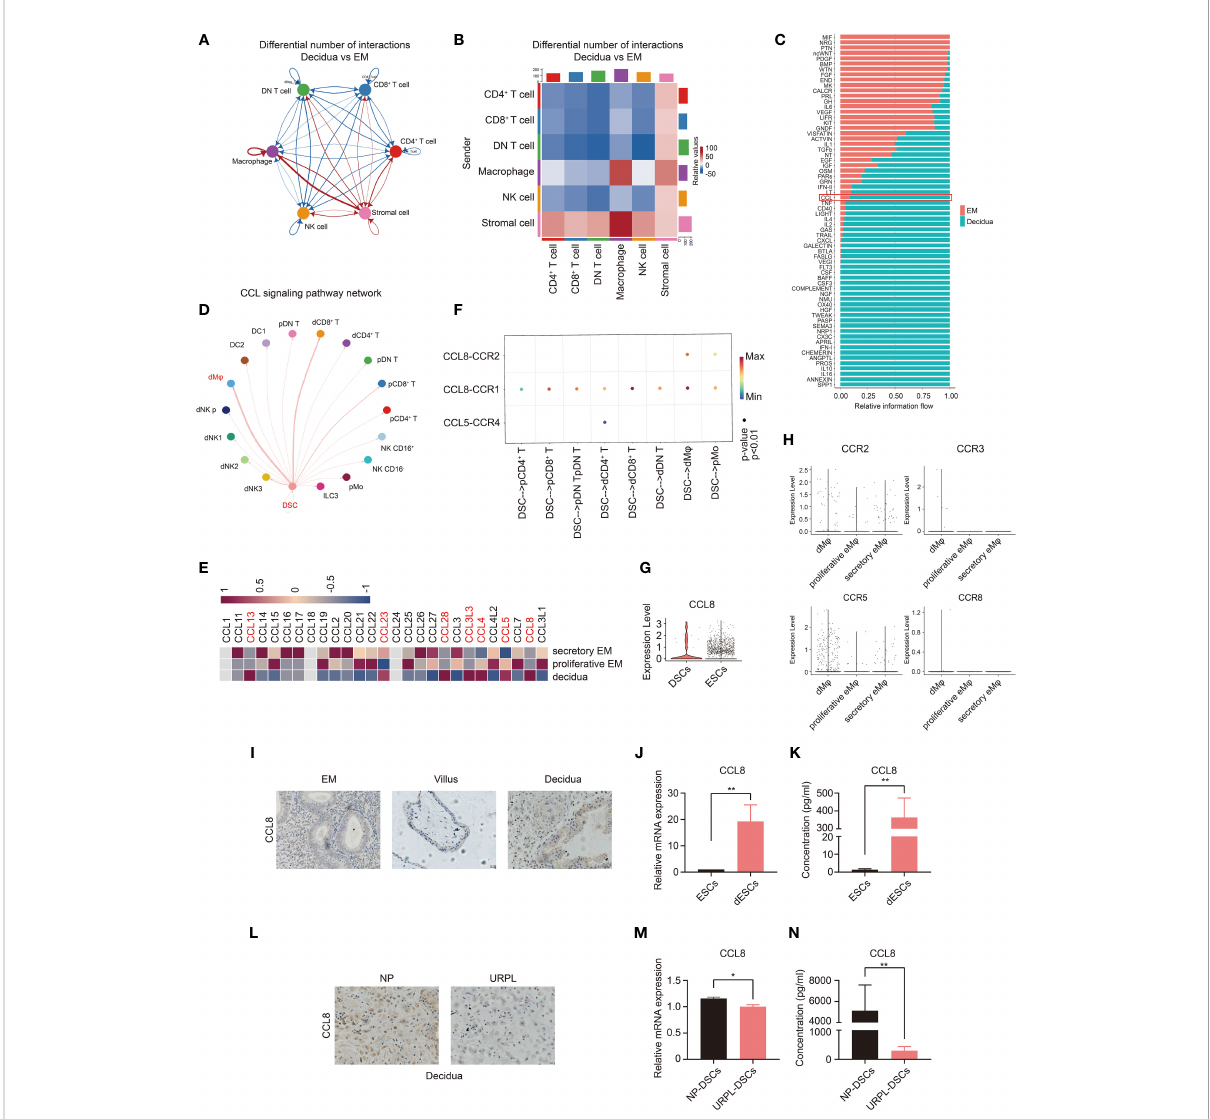
FIGURE 3 Single-cell analysis predicts the CCL8 – CCR1 interaction between DSCs and macrophages during early pregnancy. (A, B) Number of ligand – receptor pairs between any pair of two cell populations. The edge width and shade are proportional to the indicated number of ligand – receptor pairs. (C) Signaling pathways were ranked based on their differences of overall information fl ow within the inferred networks between the endometrium and decidua. (D) Inferred CCL signaling networks in the decidua (circle plot). (E) Heatmap showing the expression of selected CCL genes in the proliferative and secretory endometrium and decidua. (F) The signi fi cant ligand – receptor pairs of the CCL pathway that contributed to the signaling sending from decidual stromal cells (DSCs) to immune cells. The dot color and size illustrate the calculated communication probability and p-values. (G) The violin plot referring to log-normalized expression values of CCL8 in DSCs and endometrial stromal cells (ESCs). (H) The violin plot representing log-normalized expression values of CCL8 receptors in the endometrium and decidua. (I) Paraf fi n sections of the endometrium (n=3), villous tissue (n=3), and decidua (n=3) were tested for CCL8 expression using IHC. (J, K) The mRNA level (n=6) and CCL8 concentration (n=10) before and after in vitro decidualization of ESCs. (L) Representative IHC images of CCL8 in human decidua tissues from women with NPs (n=3) and URPL (n=3). (M, N) The mRNA level and CCL8 concentration between DSCs from women with NPs (n=6) and URPL (n=6). Data are presented as mean ± SEM. and are representative of at least two separate experiments. *p < 0.05, **p <